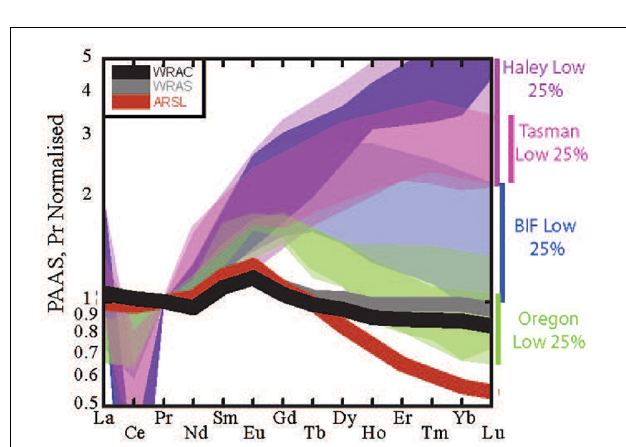
FIGURE 7 | Range of shale-normalized REE patterns of pore water with the lowest REE concentrations from the Tasman Sea (this study) and available published pore water data (Haley et al., 2004; Abbott et al., 2015b) including the pore waters corresponding to the Oregon margin sediments analyzed for clay in this study. The most and least HREE enriched ranges were observed in North Pacific samples (Haley et al., 2004; Abbott et al., 2015b) highlighting the variability in these low concentration intervals. Average river suspended load (ARSL, red), world river average clay (WRAC, gray), and world river average silt (WRAS, black) plotted for comparison (data from Bayon et al., 2015). The range of REE patterns of bottom water from the two study regions is also provided (Abbott et al., 2015a; Abbott, 2019). Normalized to PAAS values of Taylor and McLennan (1985).